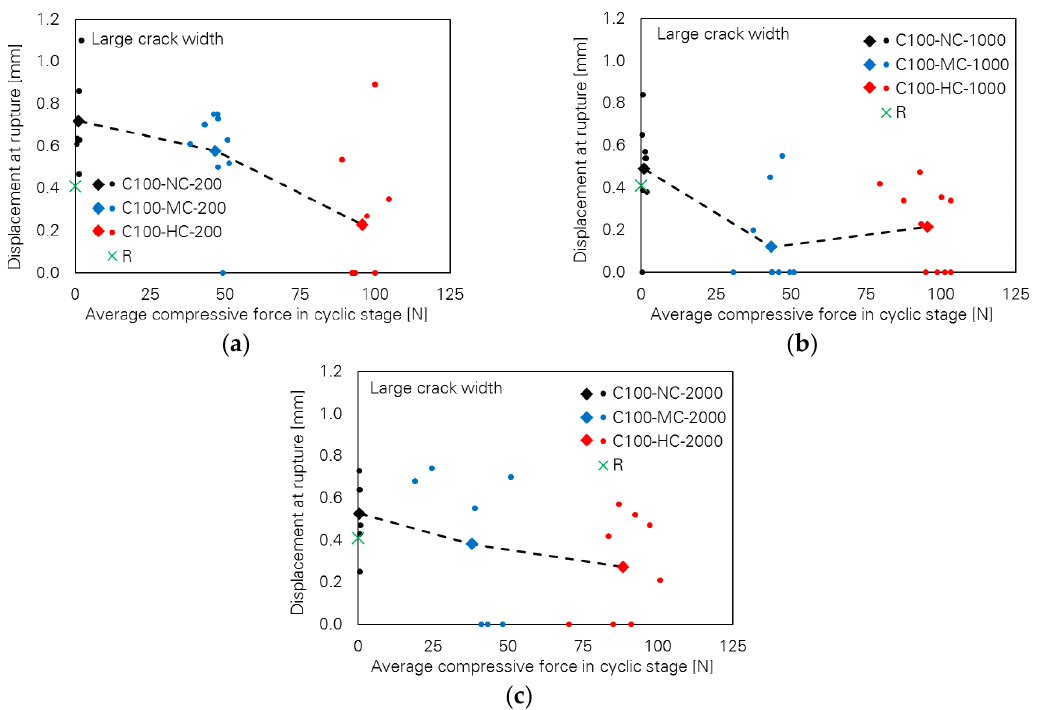
Figure 8. Influence of cyclic compressive force level on fibre displacement at rupture of the specimens with large crack width; number of cycles: ( a ) 200, ( b ) 1000 and ( c ) 2000.